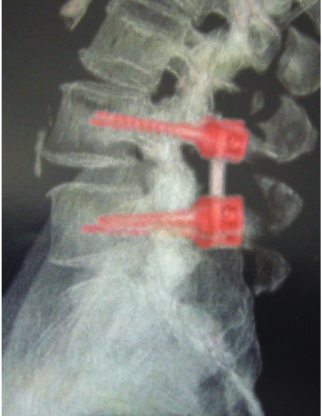
Figure 5: CT scan of another 71-yo patient with bone window shows clearly the PEEK rod and can detect a possible